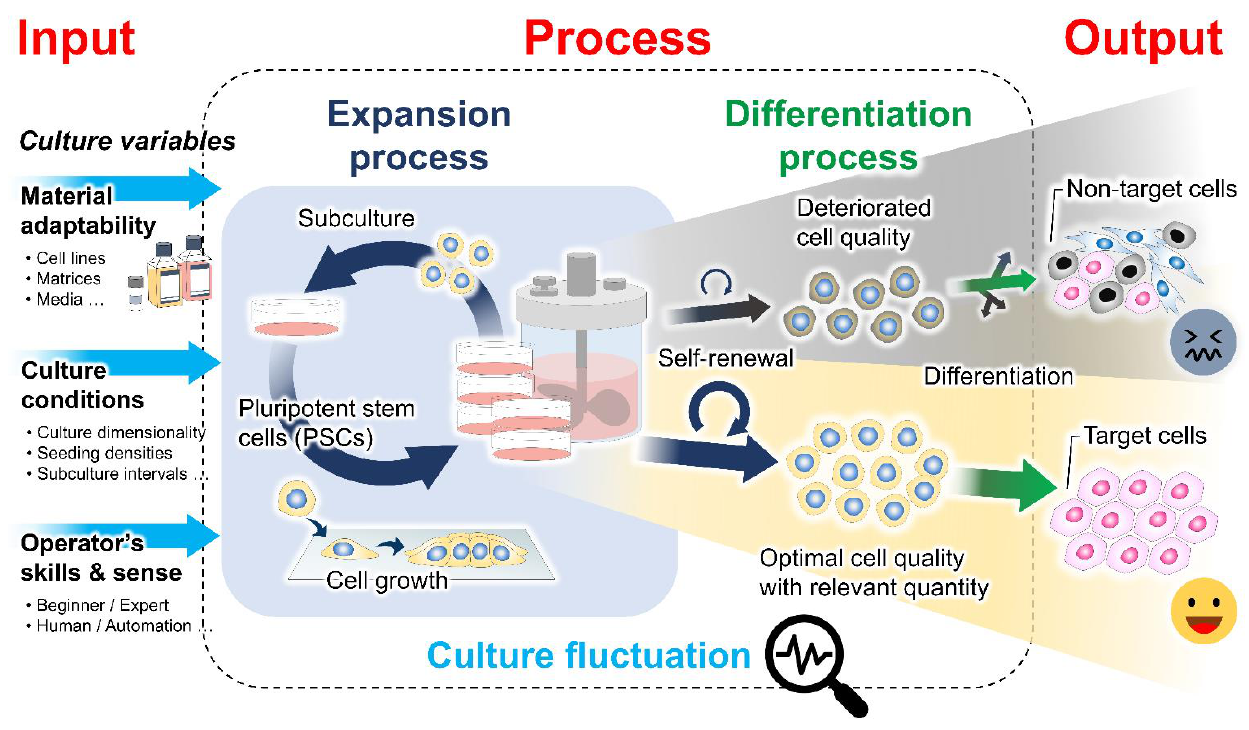
Figure 1. Culture-induced fluctuation in the cell preparation bioprocess. The expansion process contributes to producing an adequate quantity of undifferentiated cells with stable quality for further differentiation and clinical translation. The existence of cell quality variability has been recognized to be influenced by intrinsic cellular properties and extrinsic variables in the cell culture, including raw material adaptability, culture conditions, and the operator’s skills and sense. Differences in the culture inputs and spatiotemporal changes in the cell structural organization during culture determine the biomechanical properties of the cellular microenvironments. The interactions between cells and their microenvironments may result in fluctuations in the phenotypic features of the PSC